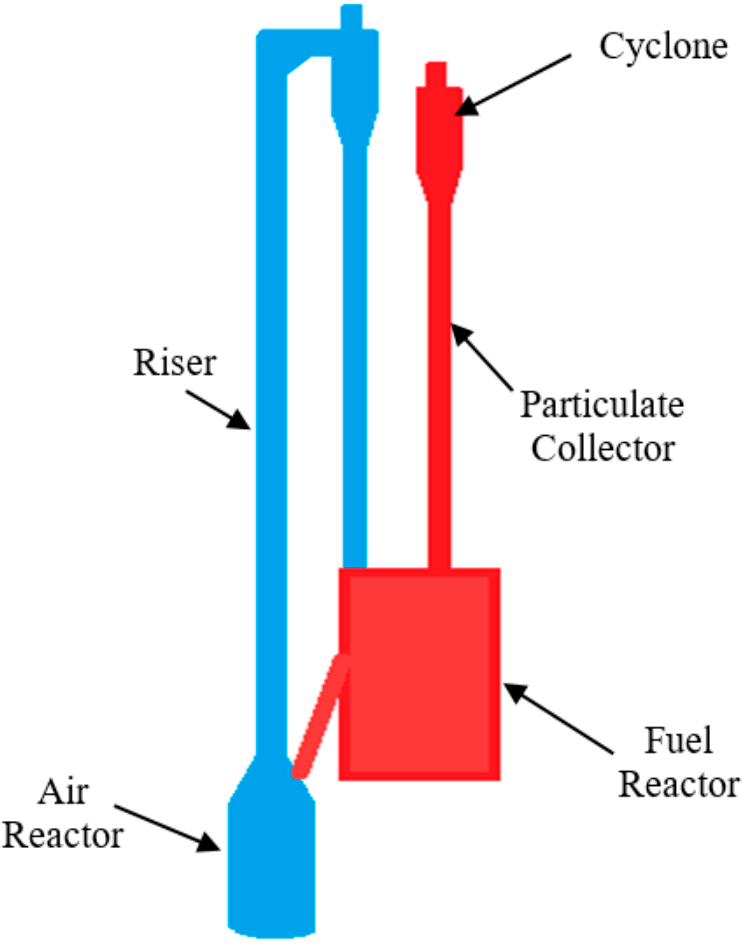
Figure 7. The scheme of the Fluidized Bed—Chemical Looping Combustion of Solid Fuel (FB-CLC-SF) unit.